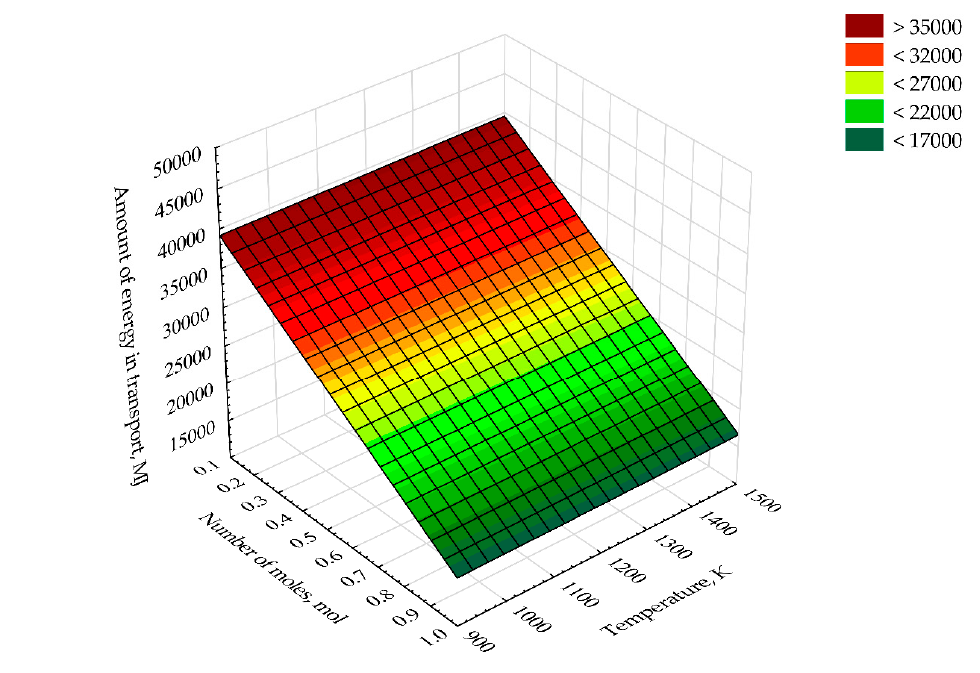
Figure 18. Energy content in the transport of syngas in the pressure vessels with a capacity of 14.960 m 3 at 200 bar at 293 K as a function of the number of moles of the gasification agent (x) and the temperature (y) of the gasification process using O 2 .